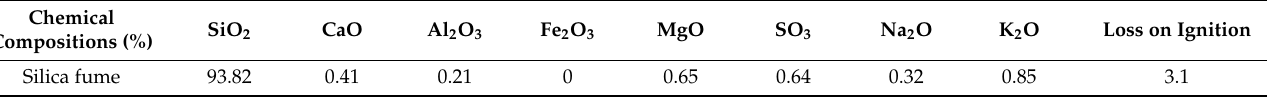
Table 4. Chemical compositions of silica fume.